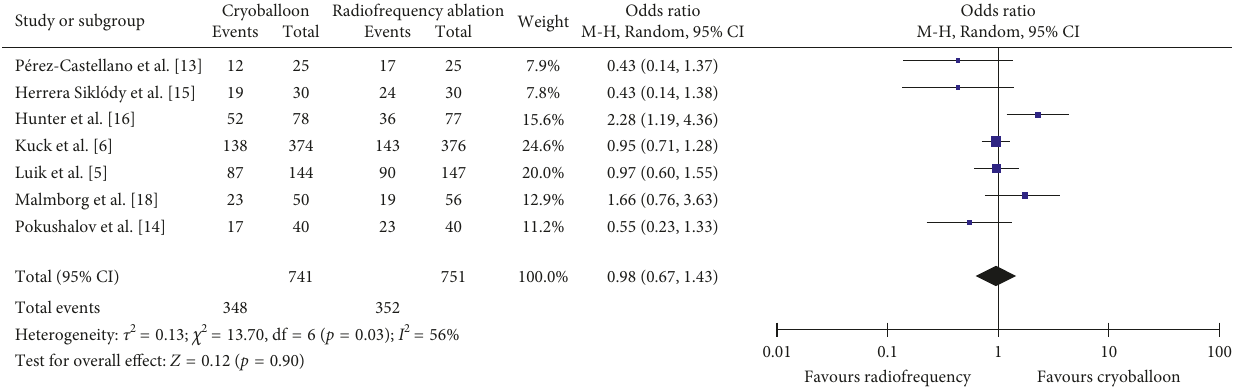
Figure 5: Mean odds ratio with 95% CI of patients free from atrial fibrillation at